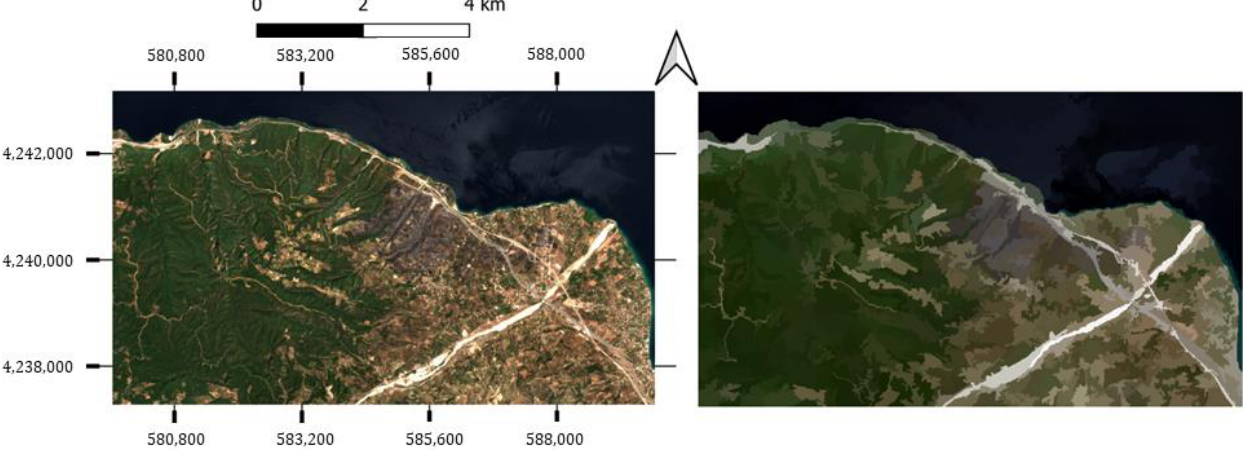
Figure 4. The post-fire RGB image of the study area in Aigialeia Municipality ( left ) and the segmen- tation map created after the application of the mean-shift algorithm ( right ).